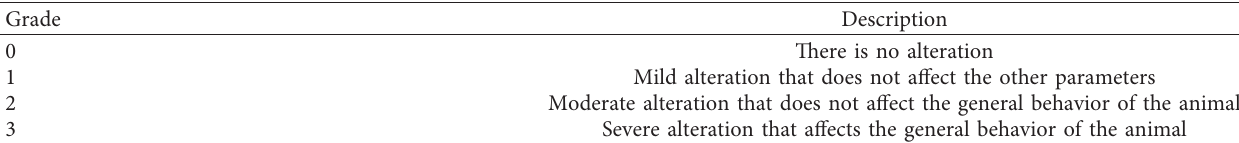
Table 4: Scale of values for animal health assessment parameters.